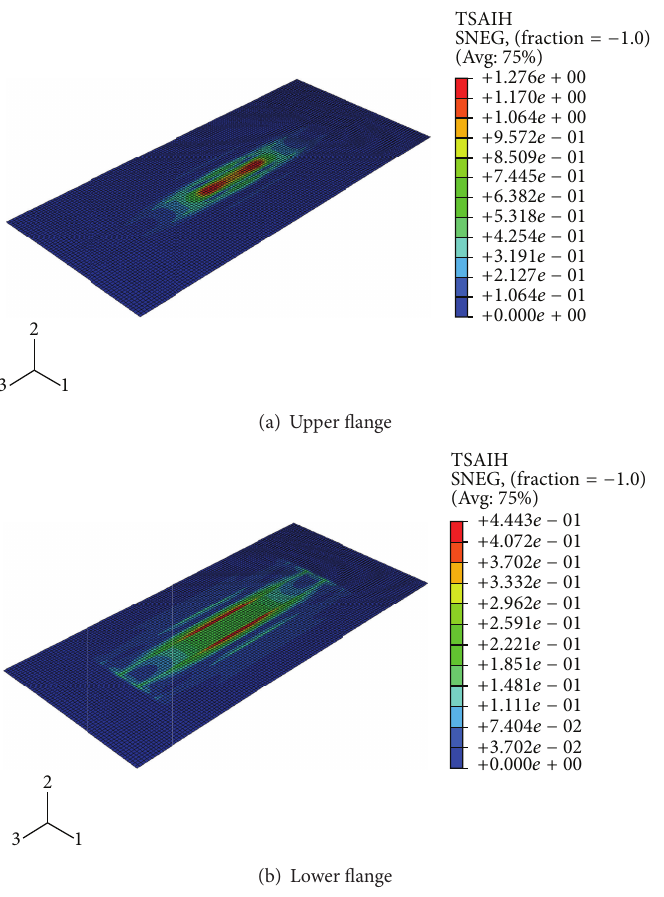
Figure 6: FRP deck failure index distribution.